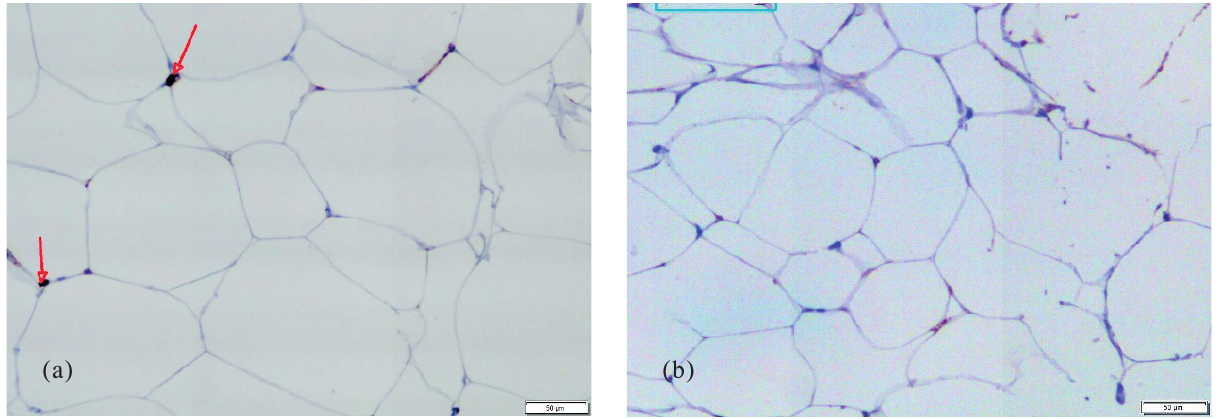
Fig. 2. White adipose tissue in patients without diabetes: (a) subcutaneous white adipose tissue (20×), the arrows indicate the CD204+ macrophages. (b) visceral white adipose tissue (20×). Immunohistochemical staining